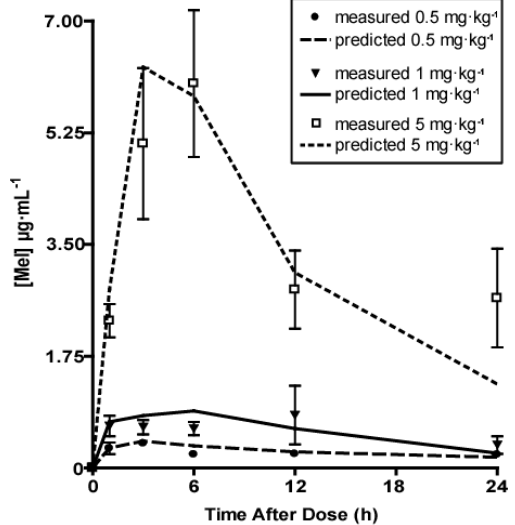
Figure 1. Plasma melatonin concentrations in preterm neonates after administration of an intragastric bolus. Measured melatonin (symbols) and predicted melatonin (lines) concentrations in preterm neonates receiving 0.5 (dot), 1 (triangle) or 5 (square) mg·kg − 1 melatonin through a nasogastric tube, analyzed 1, 3, 6, 12 and 24 h after melatonin administration. Model fitting was obtained as described in Methods.